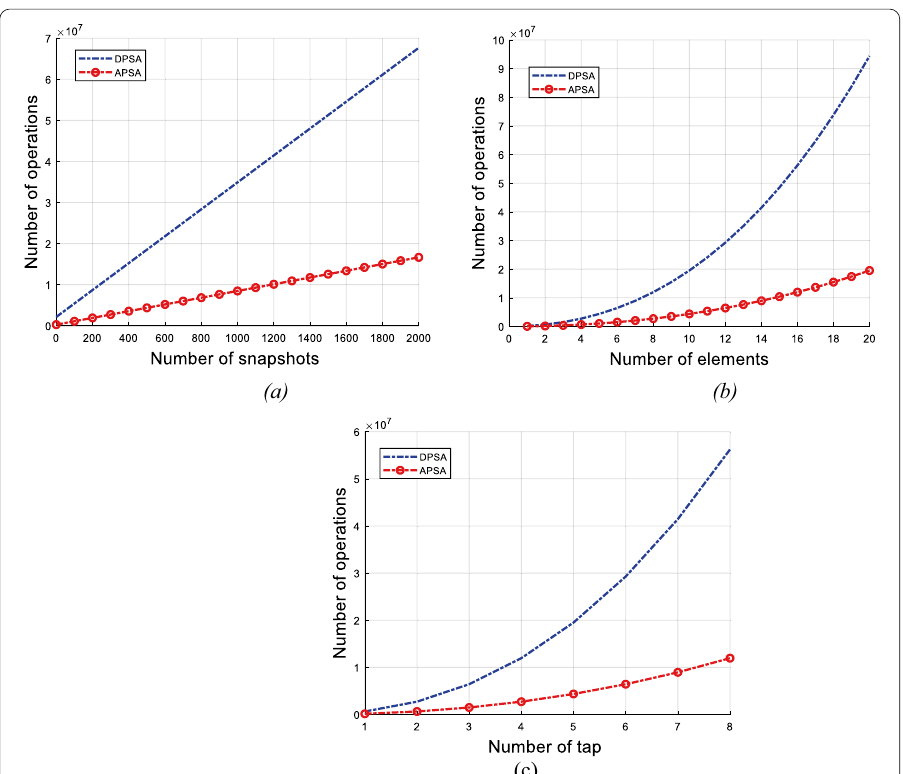
Fig. 9 Computational complexity of the APSA-STPAP and DPSA-STPAP algorithms a number of operations versus the number of samples, b number of operations versus the number of array elements, and c number of operations versus the number of time domain taps